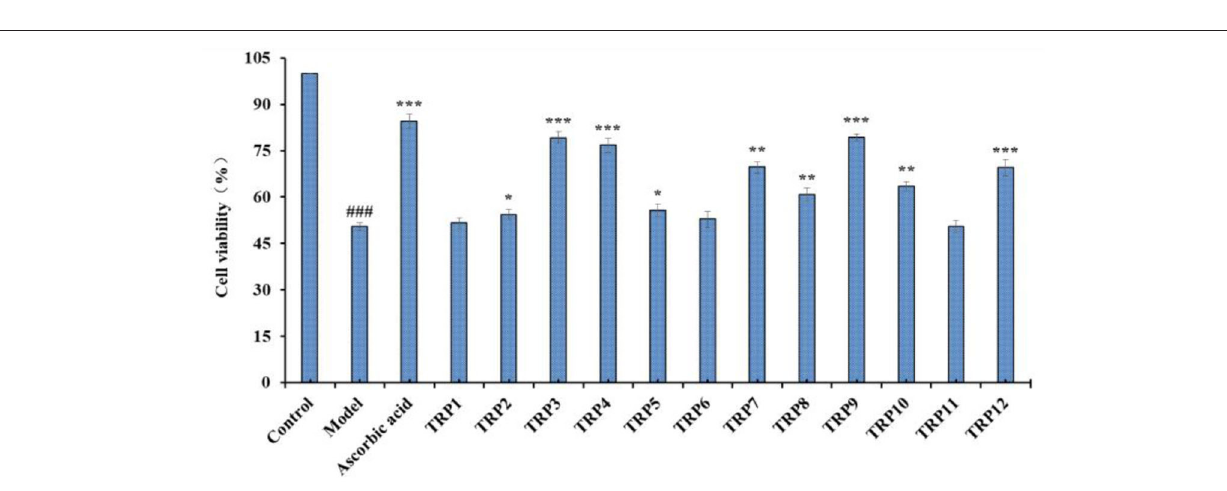
cell viability of TRP2, TRP4, TRP5, TRP7, TRP11, and